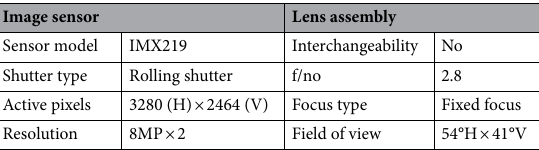
Table 2. Technical characteristics of the stereo camera.